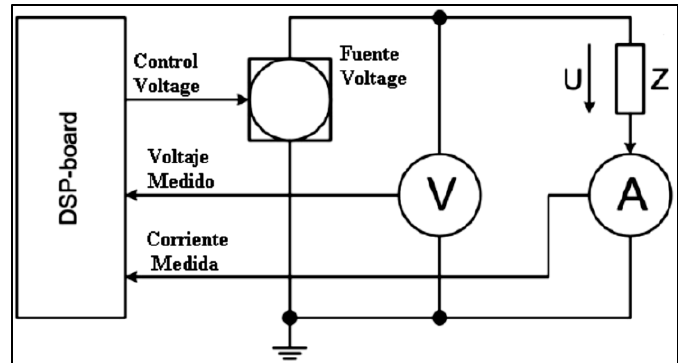
Figura 15: Circuito de medición básica FDS. Fuente: Autores, (2017).